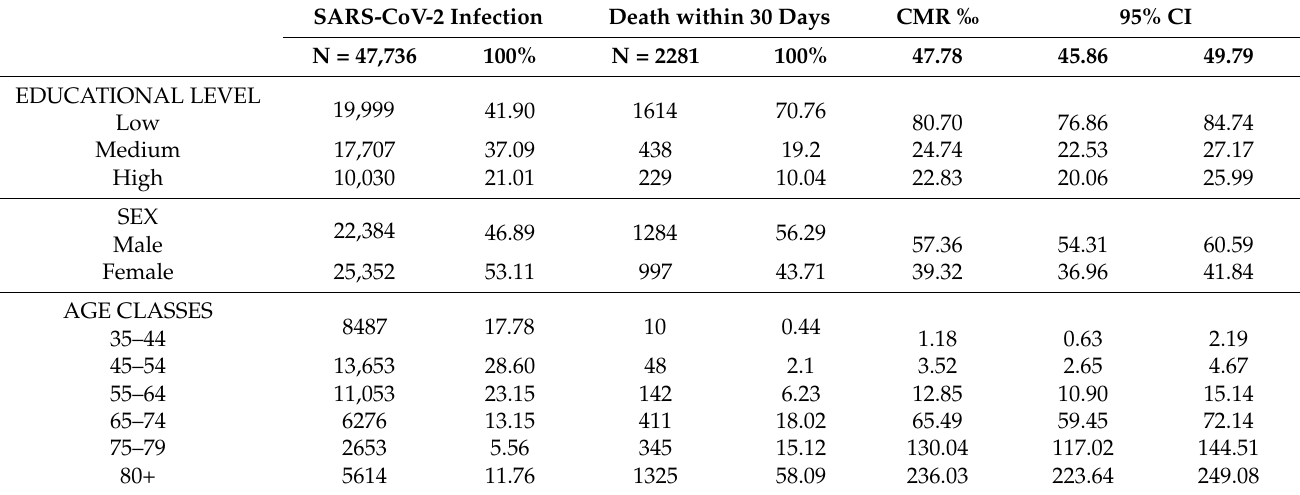
Table 2. SARS-CoV-2 infections and deaths within 30 days from infection by educational level, sex, and age. Crude Mortality Rates (CMR) with 95%CI. Rome, 35+ years old, 1 March to 31 December